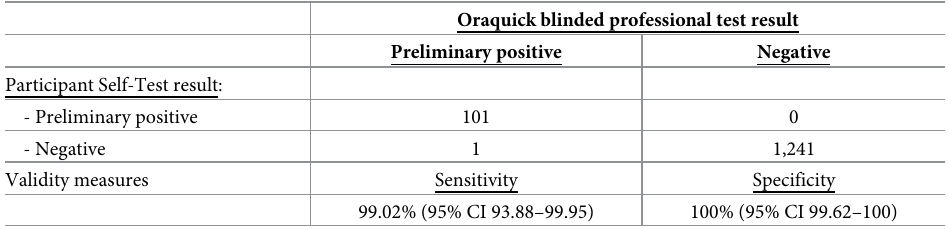
Table 2. Validity Oraquick Self-Test result versus professional user test result.